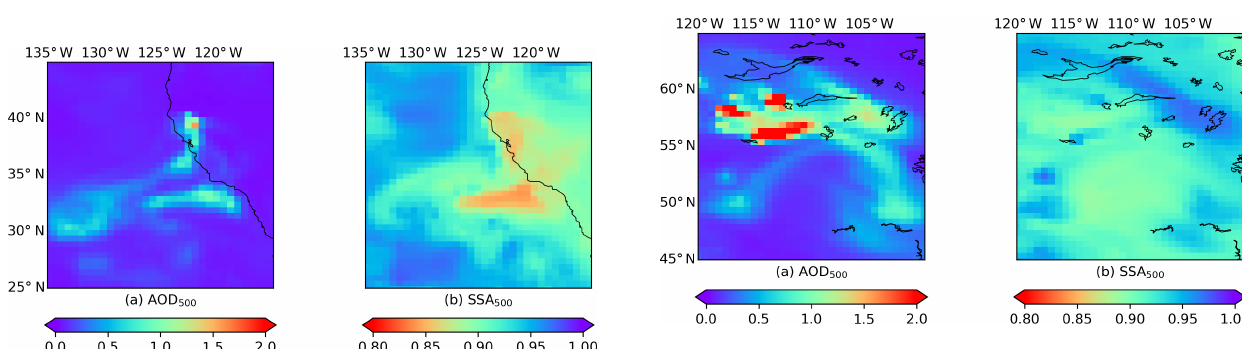
Figure C5. MERRA-2 M2T1NXAER averaged between 12:00 and 15:00LT for the Canadian fire event on 29 May 2019: (a) AOD at 500nm; (b) SSA at